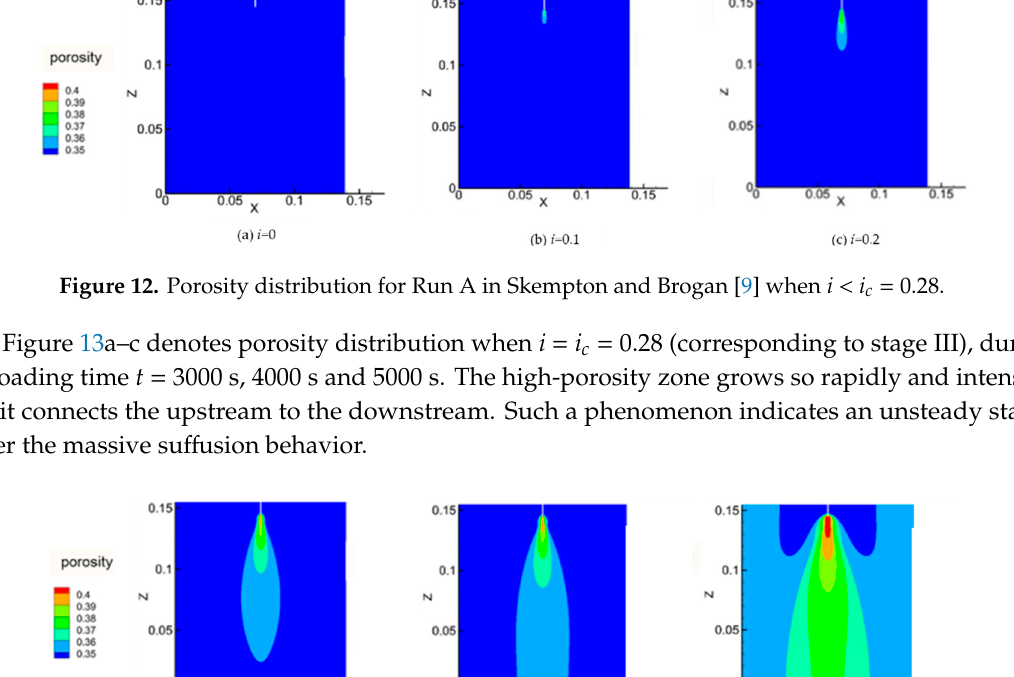
Figure 13. Porosity distribution for Run A in Skempton and Brogan [9] when i = i c = 0.28.